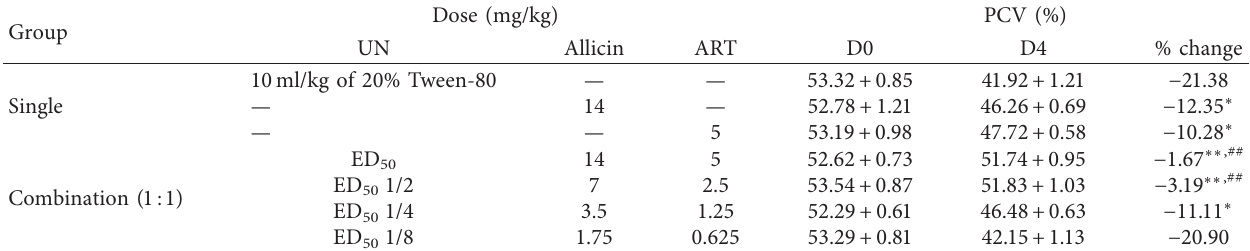
Table 2: Effect of allicin and its combination with ART on PCV in PbANKA infection in mice. Group